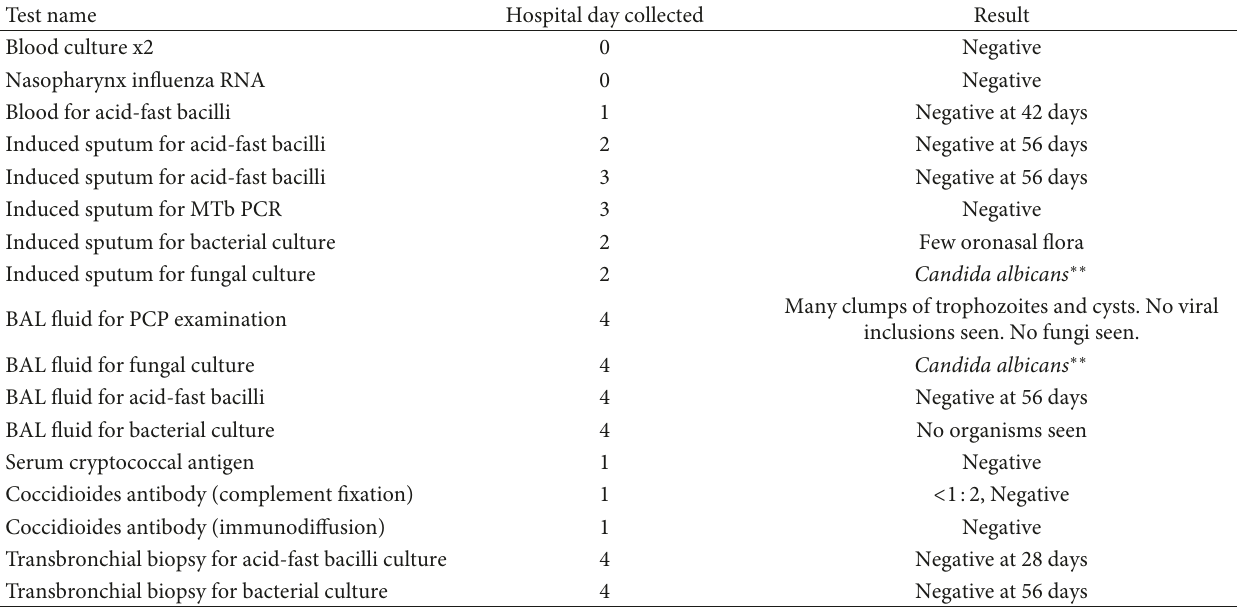
Figure 4: Transbronchial biopsy pathologic results. Pathologic evidence for PCP infection from the patient’s transbronchial biopsy specimen. (a) Hematoxylin and eosin- (H&E-) stained section demonstrates classic intra-alveolar eosinophilic foamy exudates. (b) Gomori methenamine silver (GMS) special stain demonstrates nonbudding cysts with thin walls and intracystic capsular dots, consistent with Pneumocystis jirovecii -type fungal organisms. Table 2: Microbiology